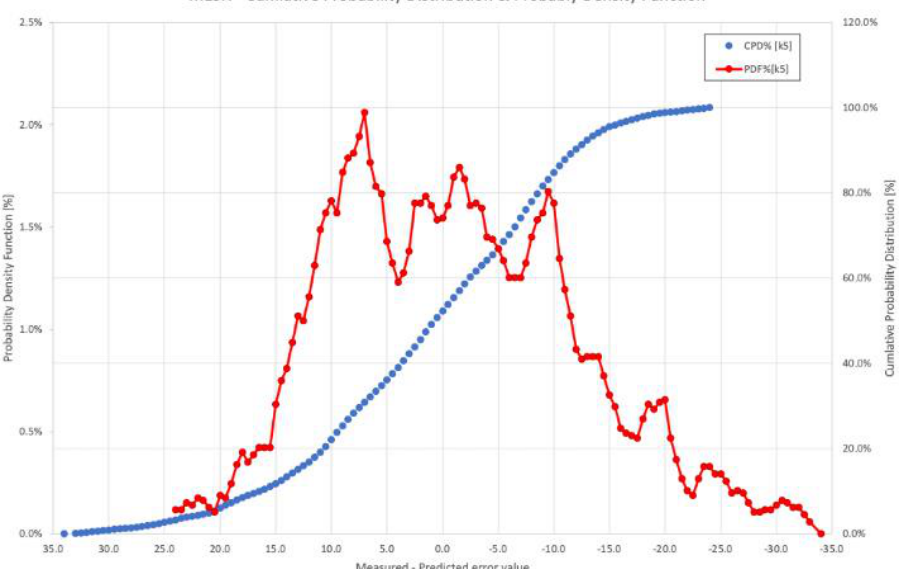
Figure 5. CDF and PDF based on a simple slope intercept model.